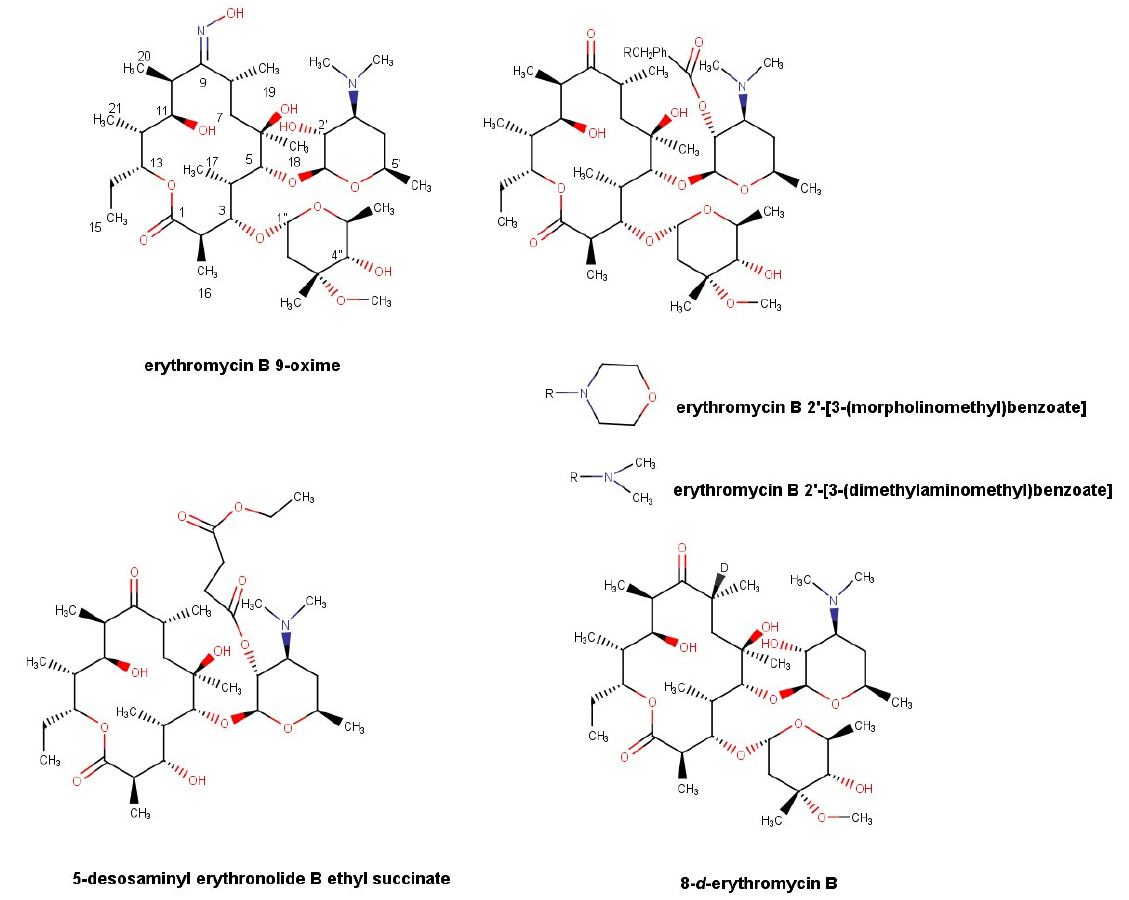
Figure 1. Investigated derivatives of erythromycin B against P. falciparum K1